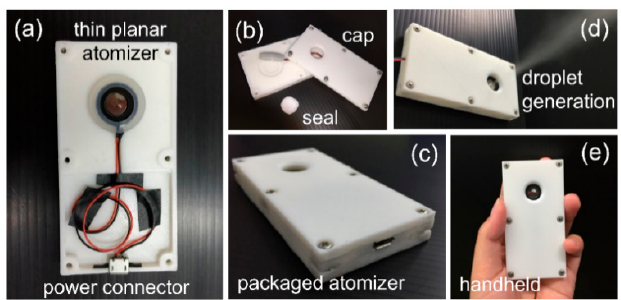
Figure 4. One portable mechatronic fluidic device for generation of droplets: ( a ) Assembly of 3D printed main body with a thin planar atomizer and a power connector for driving control of droplet generation; ( b ) packaging of the assembled body with an internal seal and an outer cap; ( c ) a packaged atomizer; ( d ) generation of water droplets from the device; ( e ) handheld, compact, and light for personal use.